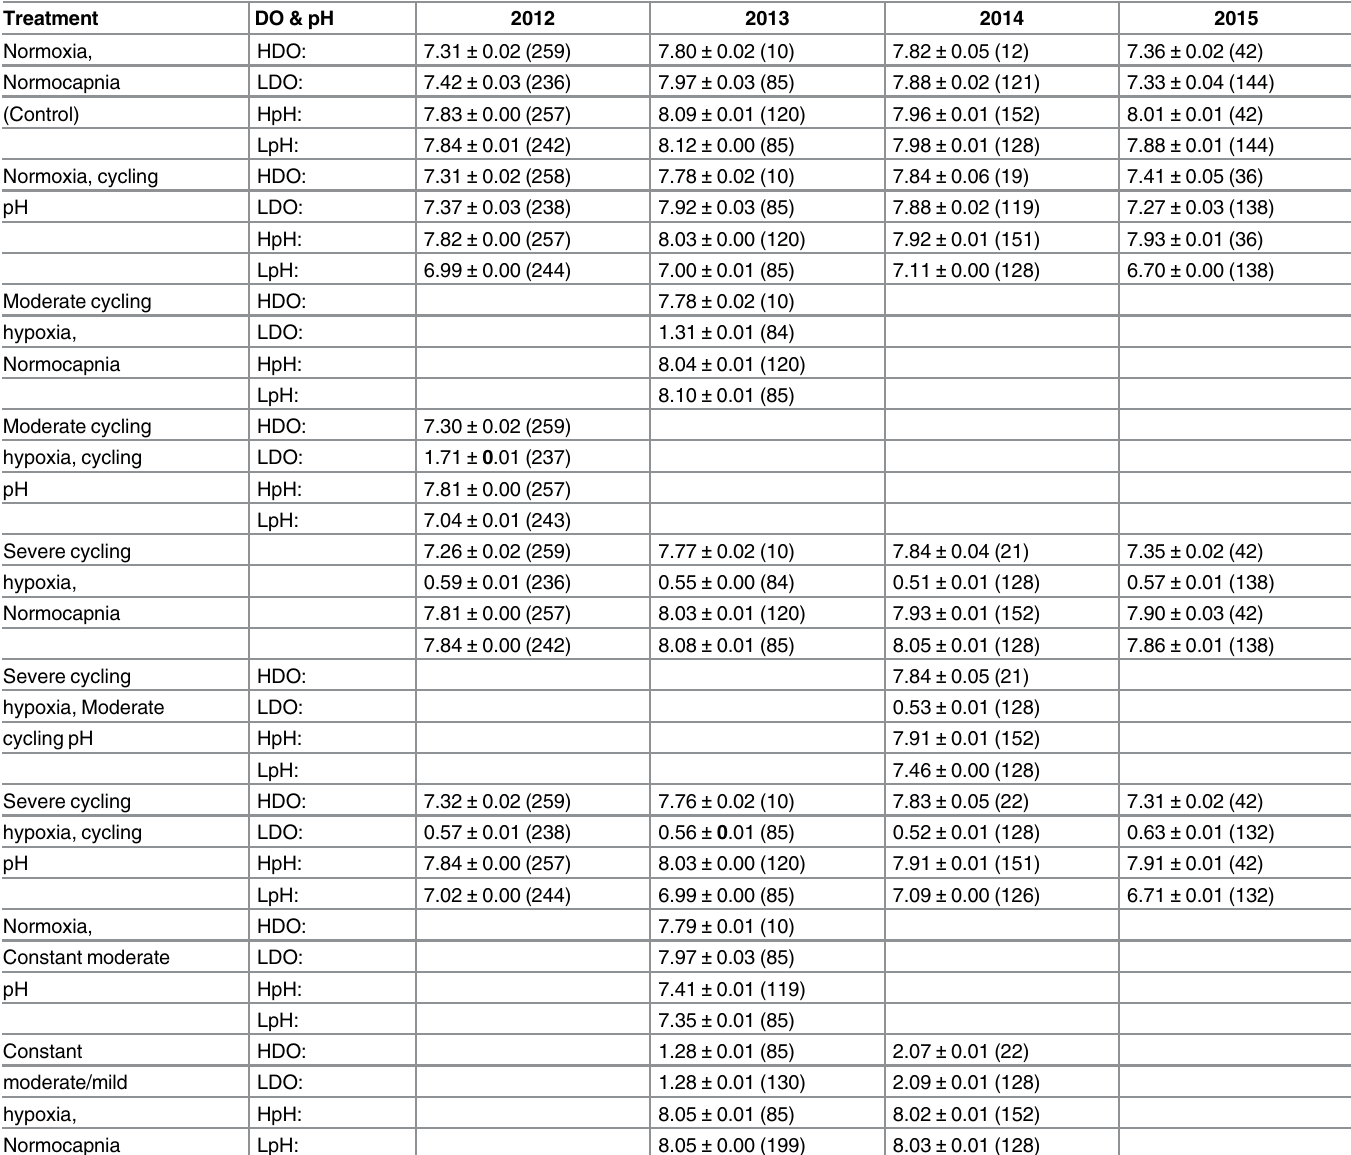
Table 1. Mean ± SE (n) DO and pH in oyster growth